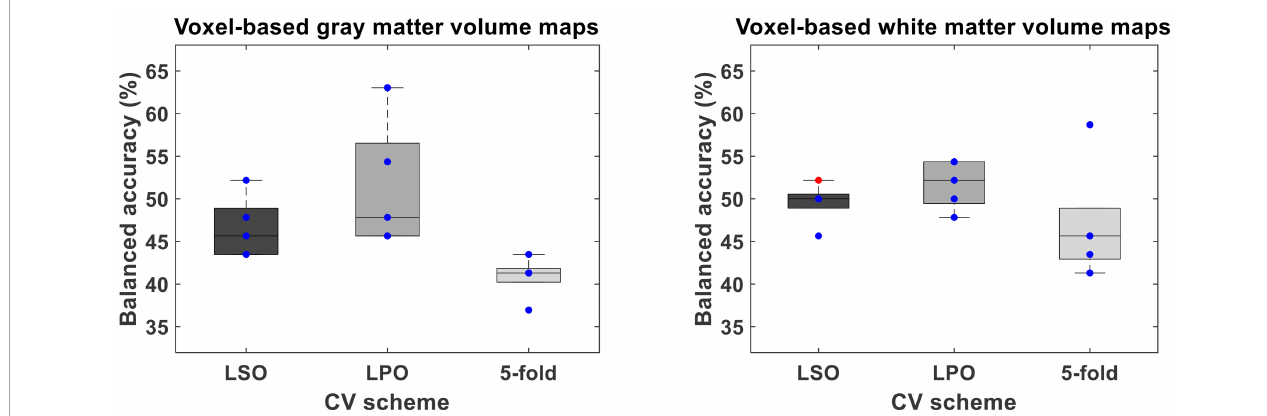
FIGURE4 Balanced accuracy across bootstrapped samples for each tested combination of voxel-wise feature type [i.e., voxel-based gray (VBGM) and white (VBWM) matter volume maps], feature dimensionality reduction through principal component analysis and cross-validation (CV) scheme [i.e., leave-one scan acquisition protocol-out (LSO) CV; leave-one per group-out (LPO) CV; and 5- fold CV. Dots represent the balanced accuracy value in each of the five bootstrapped samples and are red colored if the balanced accuracy is statistically significant (i.e., p < 0.05) or blue colored if it is not (i.e., p > 0.05). The statistical significance of the balanced accuracy in each bootstrapped sample was evaluated through permutation testing.